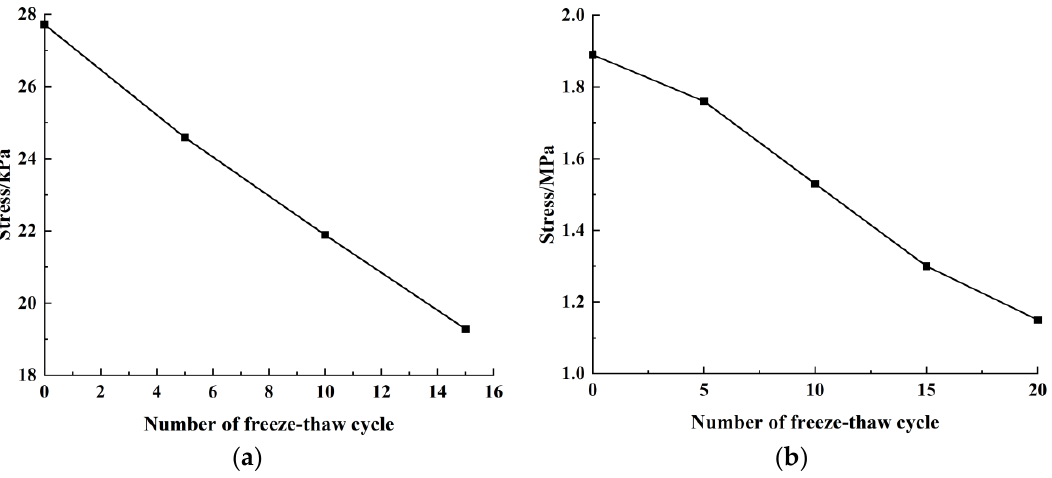
Figure 8. Water supplement during melting process: ( a ) Cement silty clay [23]; ( b ) Cement silty clay [8].